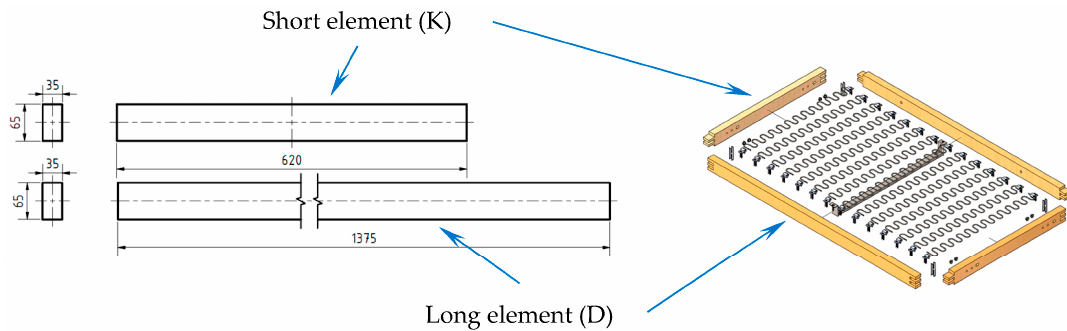
Figure 5. The target dimensions and the usage of the analyzed semi- fi nished furniture elements.